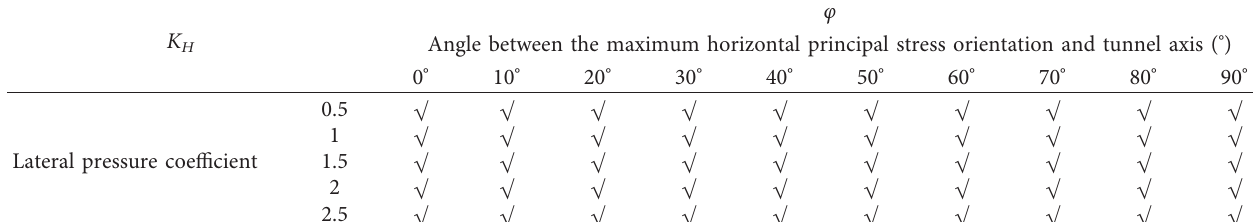
Table 2: Cases for simulation